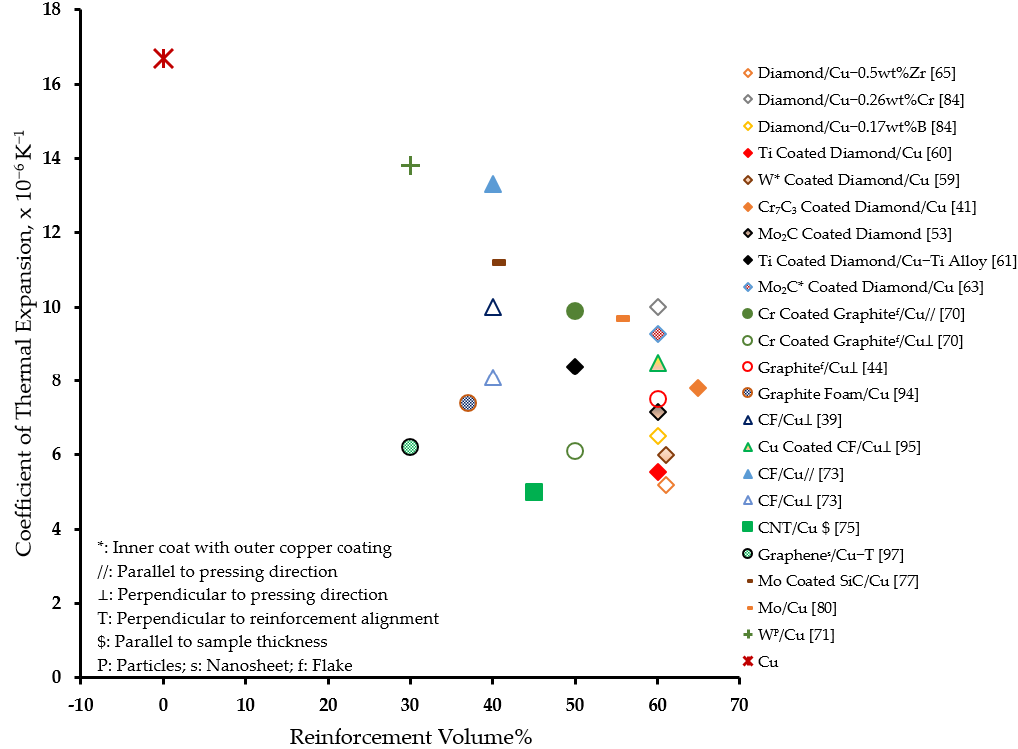
Figure 6. Effect of reinforcement on the coefficient of thermal expansion of copper matrix composites.